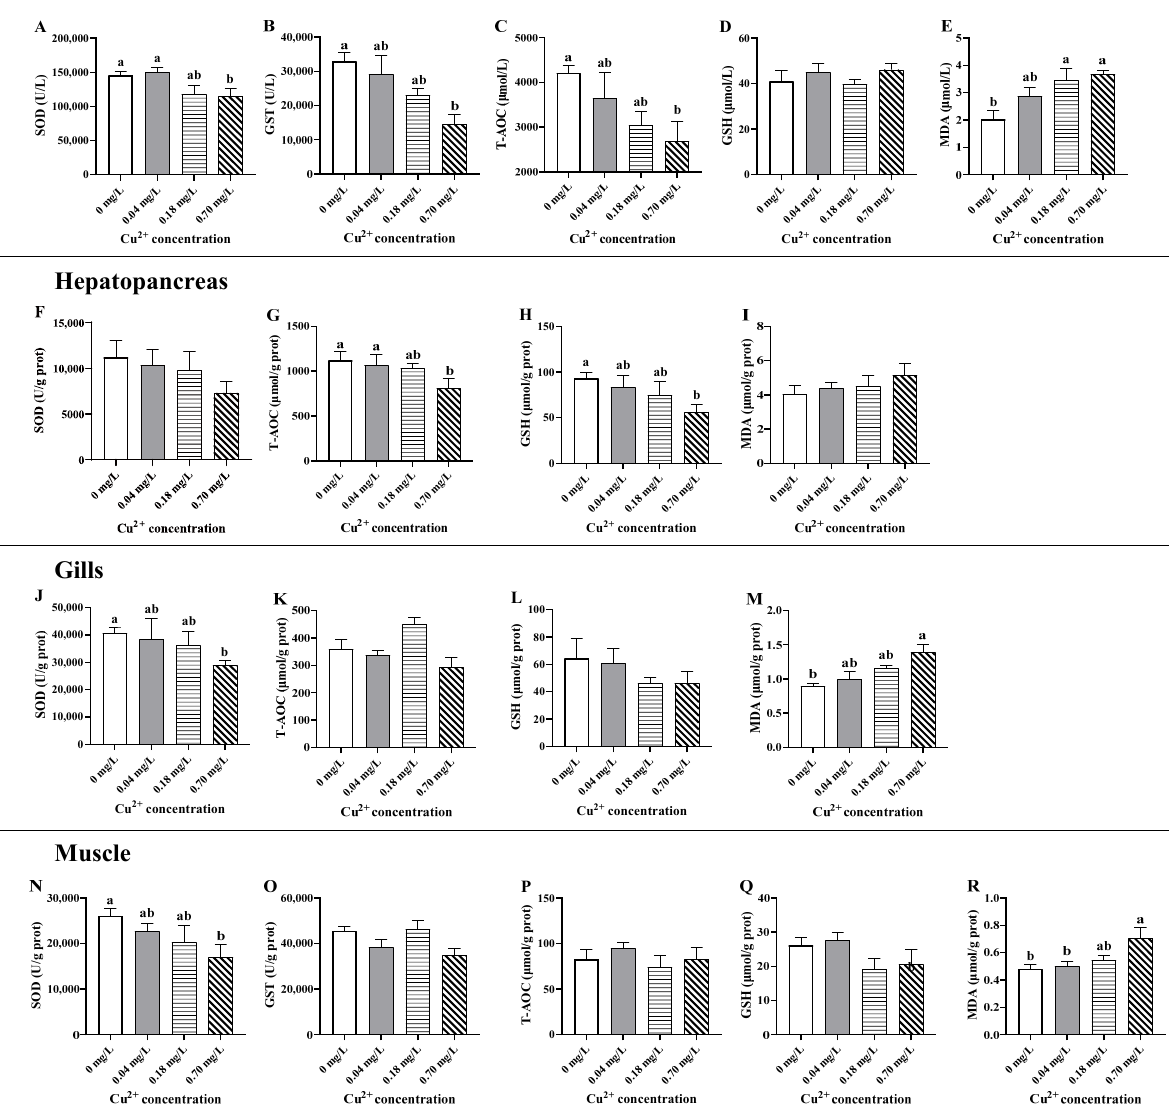
Figure 1. Changes in the oxidative stress parameters in different tissues of E. sinensis exposed to copper for 5 days. ( A – E ) hemolymph; ( F – I ) hepatopancreas; ( J – M ) gills; ( N – R ) muscle. The values are expressed the mean ± SEM ( n = 6). Different letters denote significant differences among different groups ( p < 0.05).